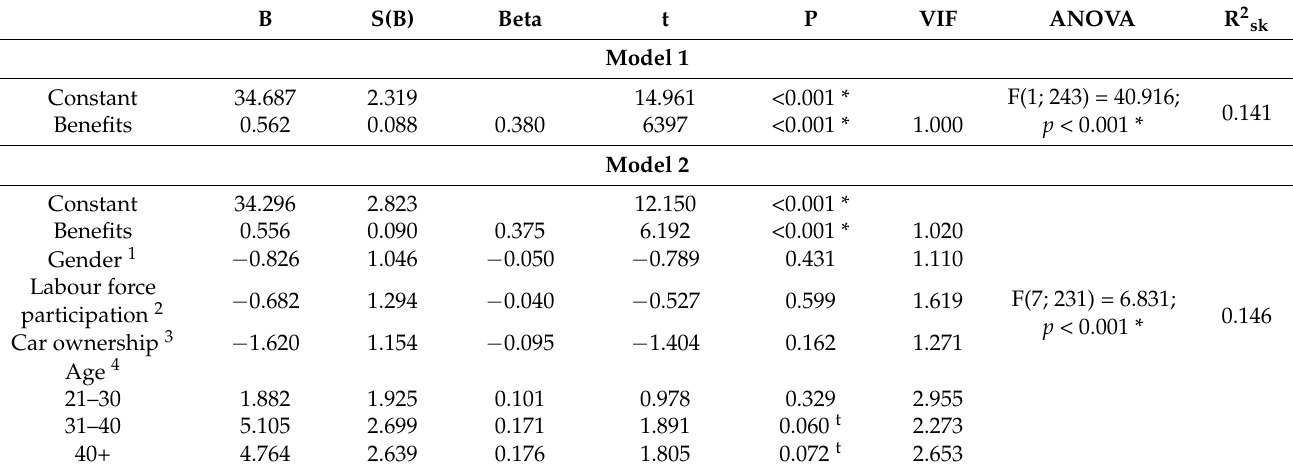
Table 10. Results of linear regression analysis: y –assessment of smart transport